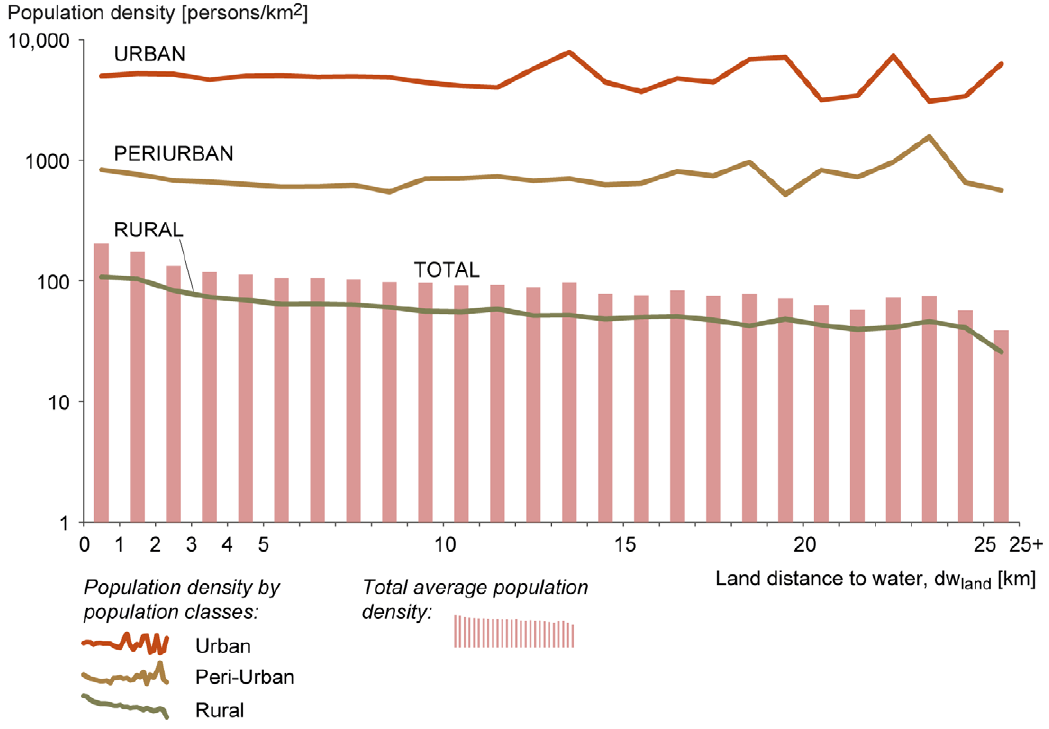
Figure 2. Relationship between land distance to water ( dw land ) and population density. The population densities for urban, peri-urban, and rural populations are presented as lines while the total average population density is presented as bars. Note: y-axis has a logarithmic scale; global average population densities are presented with a linear scale in Figure 3. doi:10.1371/journal.pone.0020578.g002 PLoS ONE |